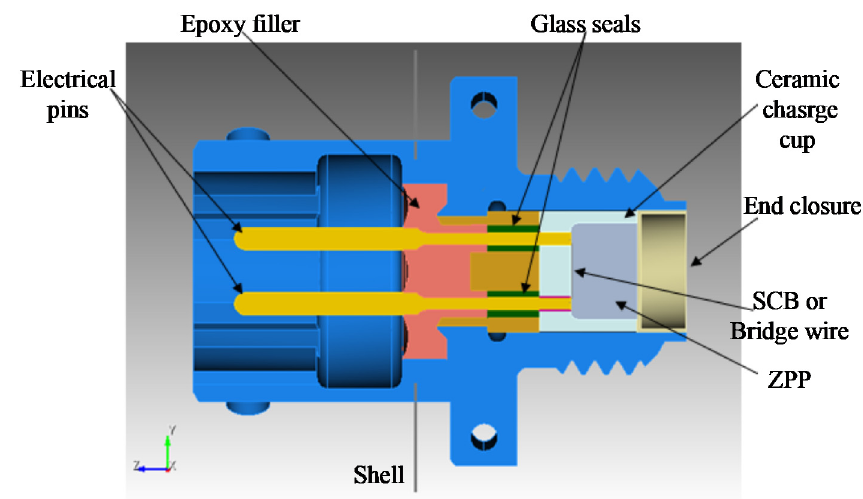
Figure 3. Traditional electro-explosive device.